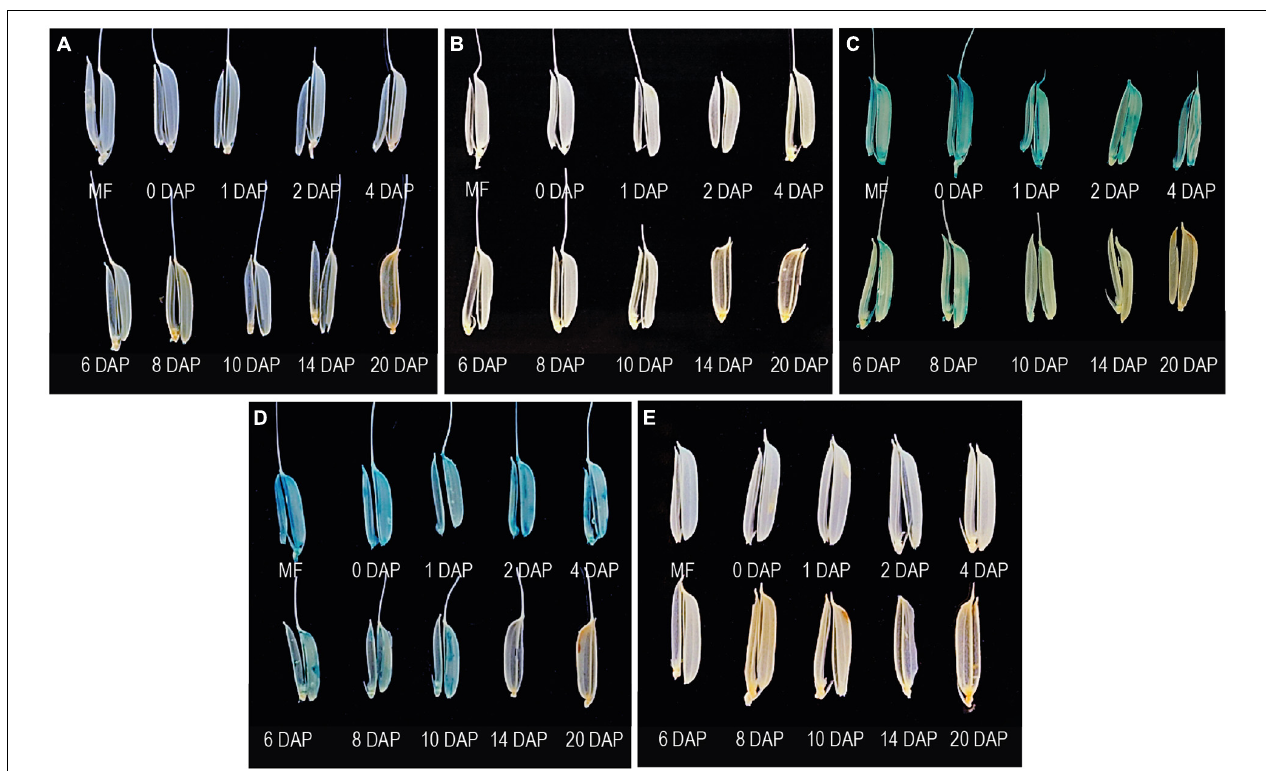
FIGURE 6 | Analysis of GUS expression in the lemma and palea in WT and transgenic plants beginning from the mature floret (MF) and post-fertilization seed development stages in 0–20 DAP. The panel shows the GUS accumulation patterns in the lemma and palea of (A) WT, (B)